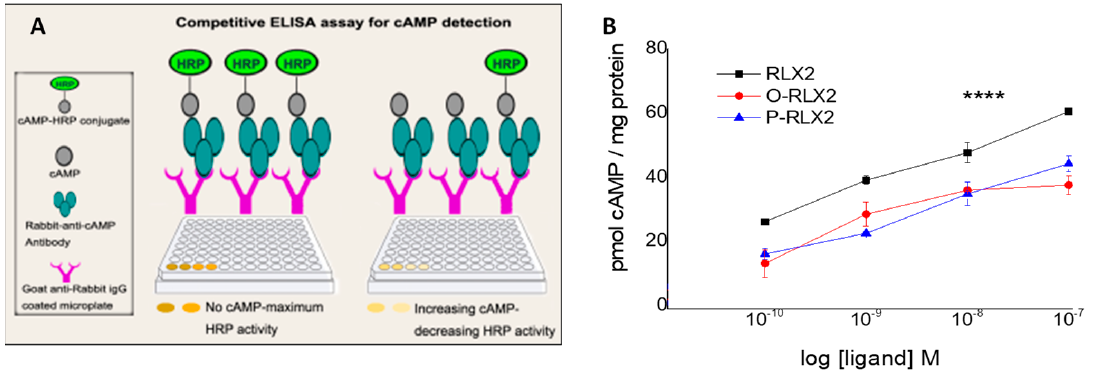
Figure 5. ( A ). Cyclic adenosine monophosphate (cAMP) immunoassay method diagram. ( B ). cAMP dose-response curve after treatment of cells with free RLX2, O-RLX2, or P-RLX2. cAMP concentration was measured with the cAMP immunoassay, and expressed as pmol cAMP per ug of protein, for each dose. **** p < 0.0001.